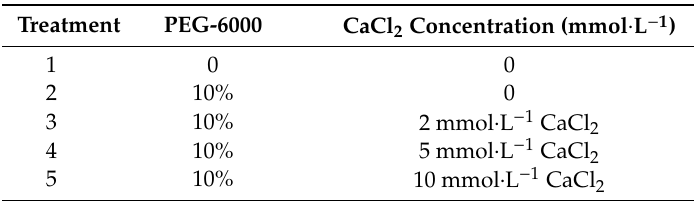
Table 1. Treatments of the